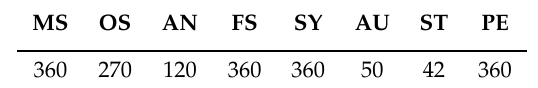
Table 2. The number of images for each algal species captured by the FlowCAM.